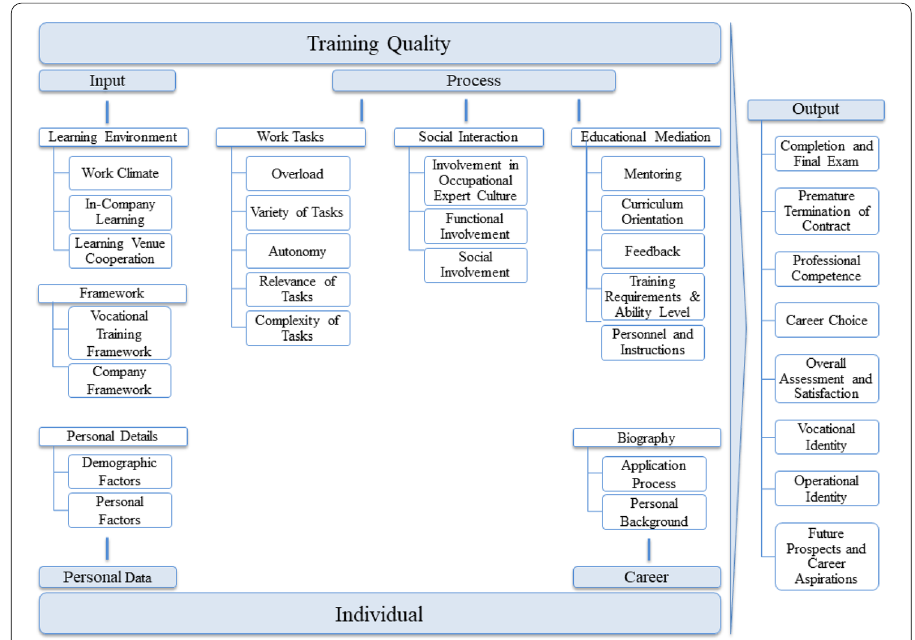
Fig. 4 Operationalisation of training quality (Böhn and Deutscher